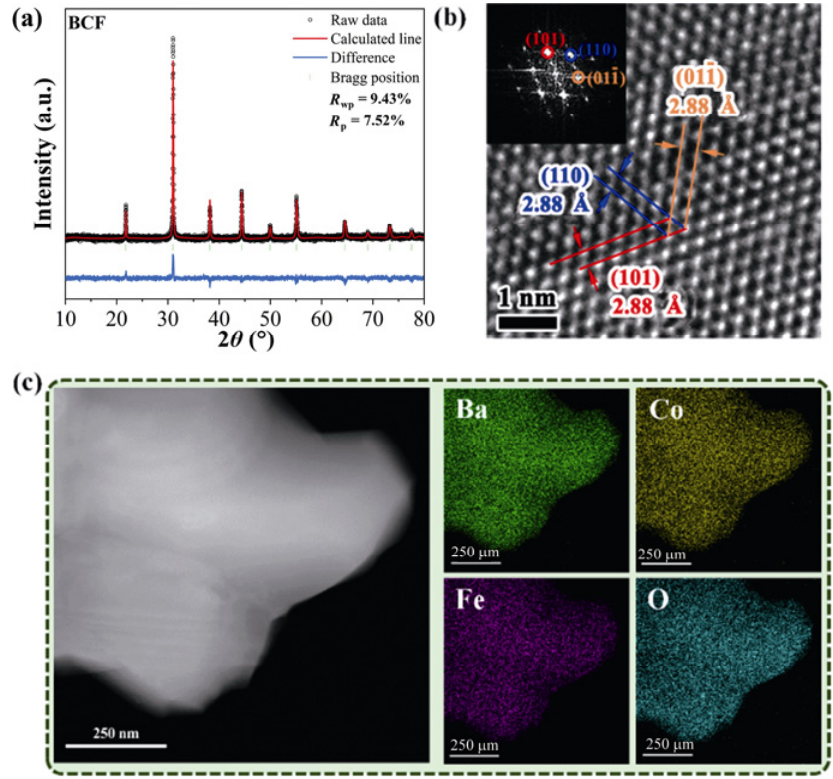
Fig. 2 (a) Rietveld structure refinement and (b) HRTEM image for BCF; (c) TEM elemental mappings for